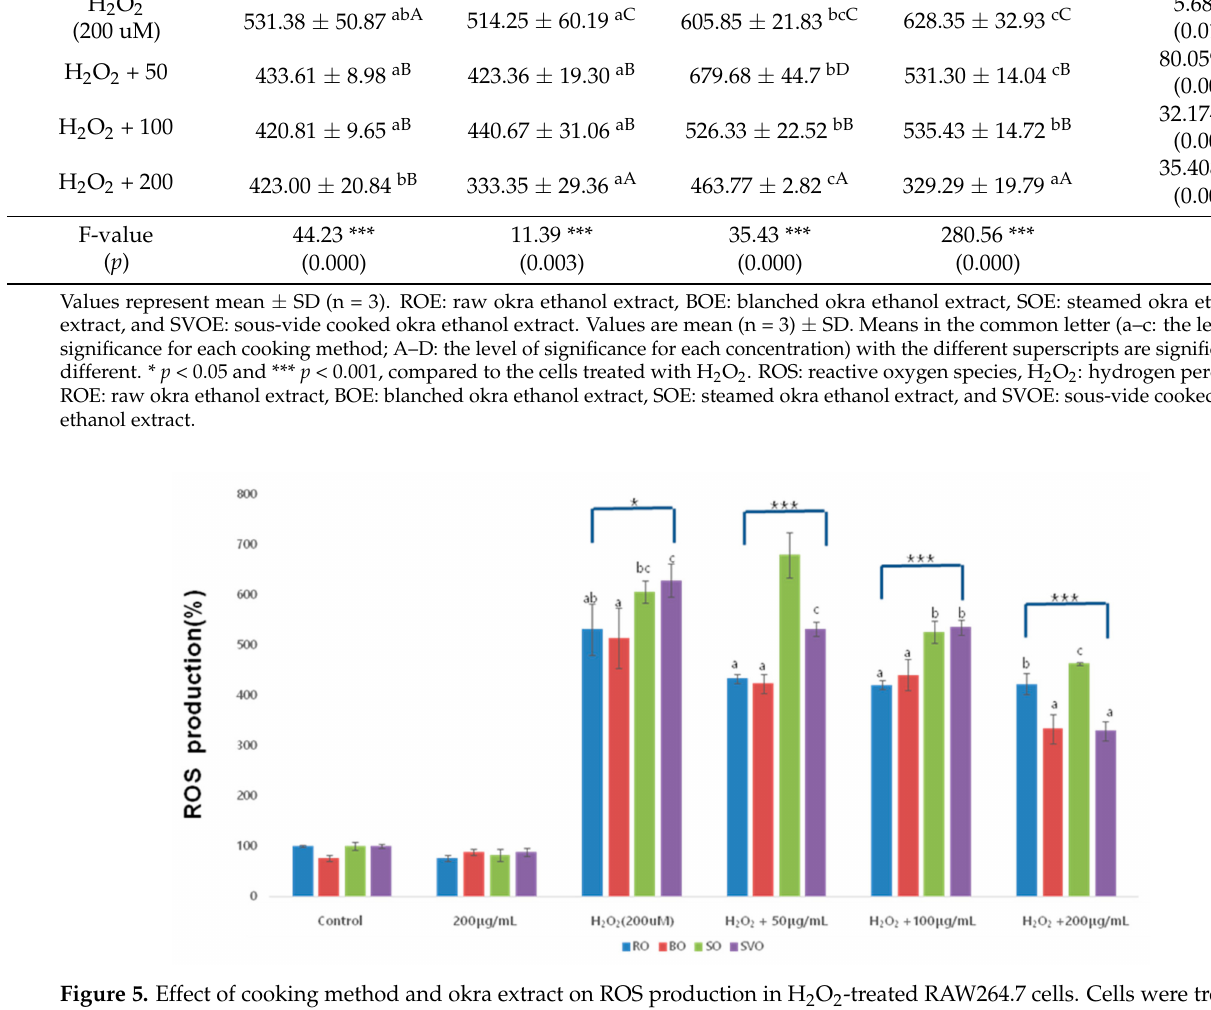
Figure 5. Effect of cooking method and okra extract on ROS production in H 2 O 2 -treated RAW264.7 cells. Cells were treated with ROE, BOE, SOE, and SVOE (50, 100, 200 µ g/mL) and 200 µ M H 2 O 2 . The ROS production was analyzed by flow cytometry. Each bar represents the mean ± SD. *, *** Significance of okra cooking method. Significant values are represented by a–c (* p < 0.05, *** p < 0.001, compared to the 200 µ M H 2 O 2 group). ROS: reactive oxygen species, H 2 O 2 : hydrogen peroxide, ROE: raw okra ethanol extract, BOE: blanched okra ethanol extract, SOE: steamed okra ethanol extract, and SVOE: sous-vide cooked okra ethanol